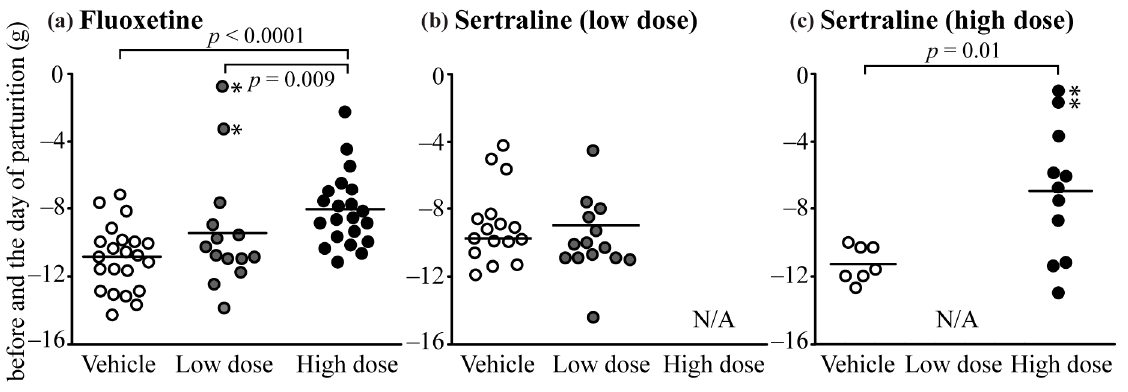
Figure 3. Maternal weight change between the last day of pregnancy and the day of parturition in the fluoxetine ( a ) and sertraline ( b , c ) studies. * Denotes dams that were euthanized after parturition and had fully developed dead pups in the